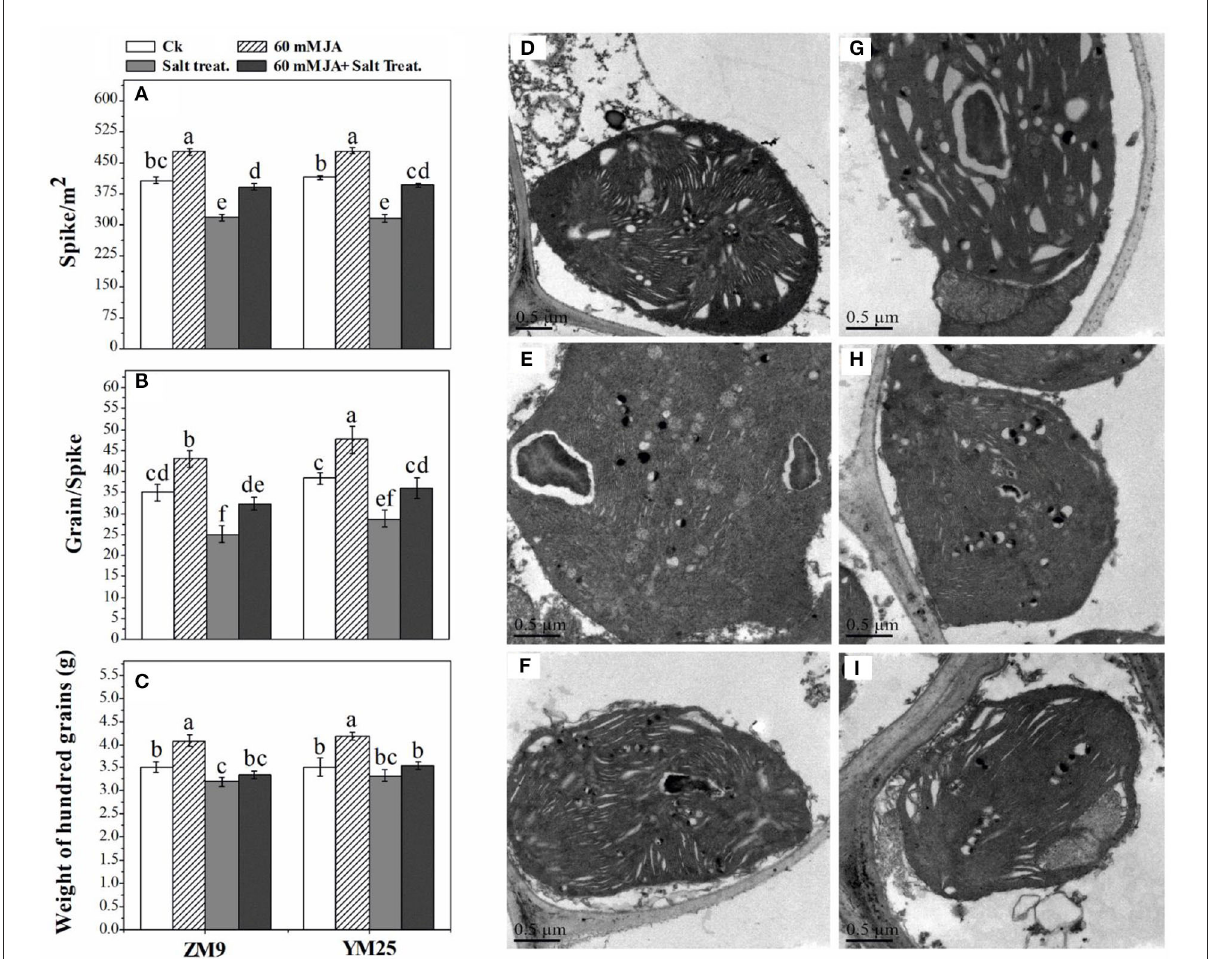
FIGURE6 Effect of JA priming on Spike /m 2 (A) , grains/spike (B) , and weight of 100 grains [g (C) ]; the ultrastructure of the leaf of two wheat cultivars Mai9 (ZM9, salt-sensitive) and Yang Mai25 (YM25, salt-tolerant) under salinity stress, CK [without priming under normal conditions in YM25 (D) and ZM9 (G) ]; S1 [exposed to salinity without JA priming in YM25 (E) and ZM9 (H) ]; JA priming + S1 [exposed to salinity with JA priming in YM25 (F) and ZM9 (I)